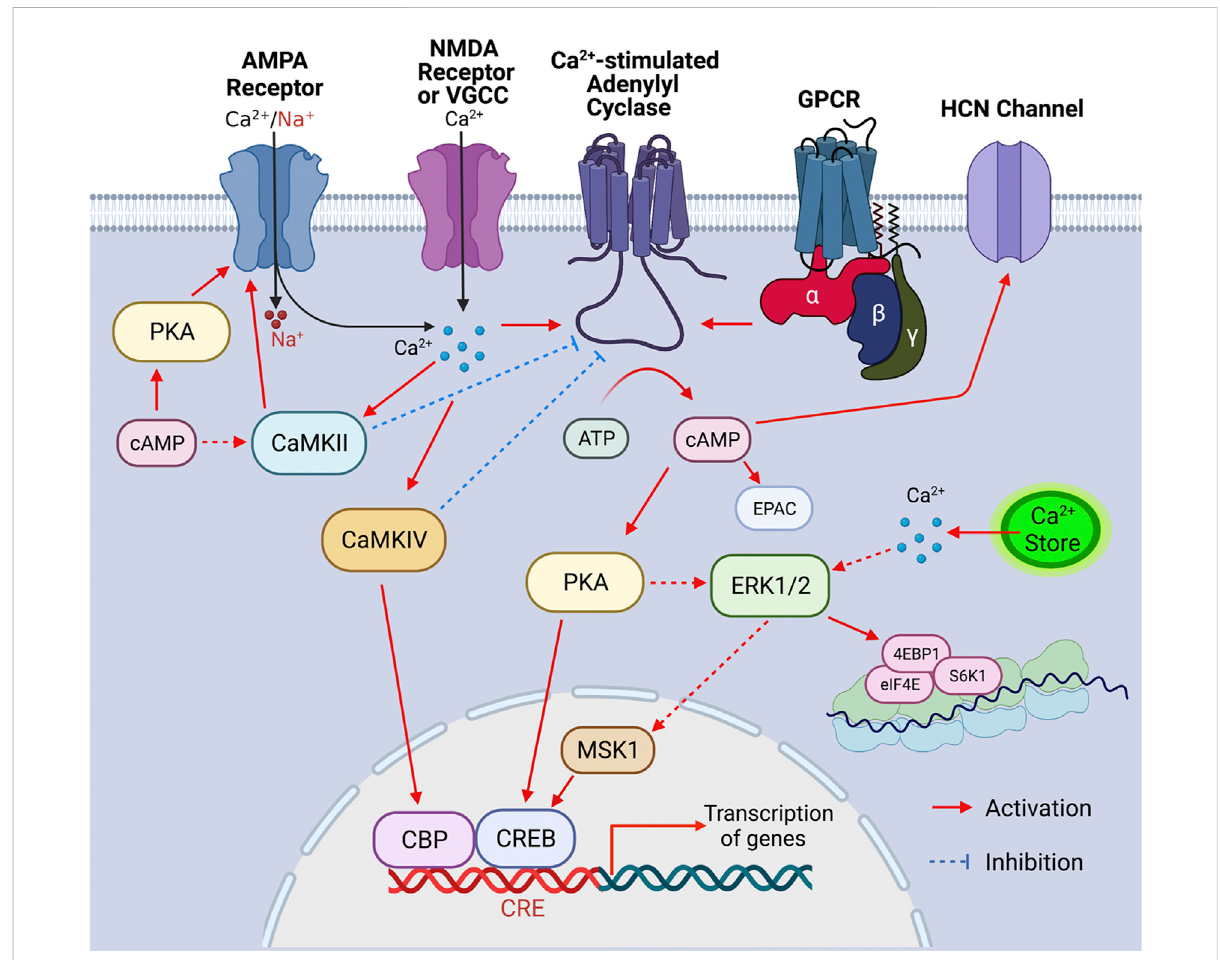
FIGURE 1 Signaling cascade triggered by the activation of Ca 2+ -stimulated ADCYs. Upon the activation of GPCR, Ca 2+ in fl ux through Ca 2+ channels (such as VGCC, NMDAR, and Ca 2+ -permeable AMPAR) and/or Ca 2+ release from internal store, the Ca 2+ -stimulated ADCYs are activated, leading to increased production of cAMP. The upregulation of cAMP activates PKA, which causes phosphorylation of CREB, ERK 1/2 (indirectly), CaMKII (indirectly) and GluR1 (at S845), leading to activation of these molecules. Increase of intracellular Ca 2+ leads to activation of ERK 1/2 (indirectly), CaMKII, and CaMKIV, which, in turn, activate MSK1/CREB, GluR1 phosphorylation (at S831), and CBP (CREB binding protein), respectively. The activated CBP/CREB triggers CRE (cAMP responsive element)-mediated gene transcription. The ERK 1/2 -mediated activation of eIF4E, 4EBP1, and S6K1 may enhance ribosome activity and lead to increase of protein translation. The Ca 2+ -stimulated CaMKIV and CaMKII may lead to feedback inhibition of ADCY1 and ADCY3, respectively. Other main aspects of cAMP effect include the cAMP-mediated EPAC (exchange protein directly activated by cAMP) activation and cAMP-facilitated opening of the HCN (hyperpolarization-activated cyclic nucleotide-gated)